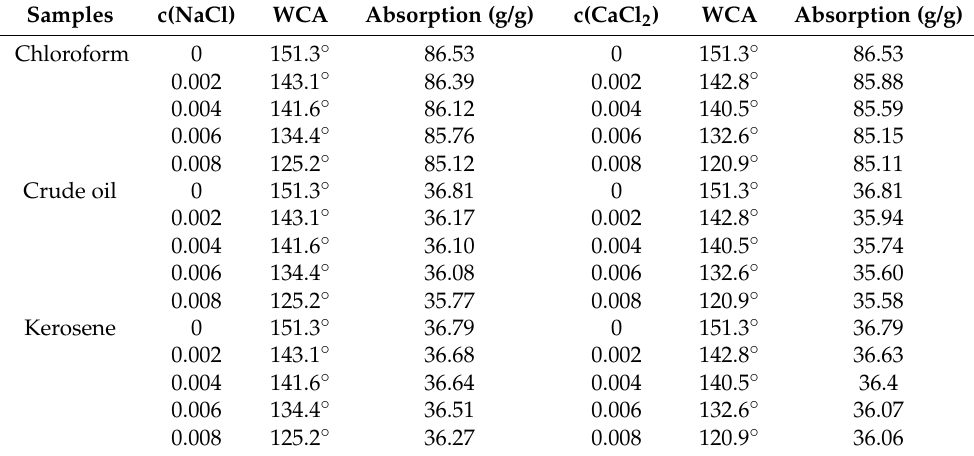
Table 4. Effect of ionic strength on oil absorption capacity (20 ◦ C).